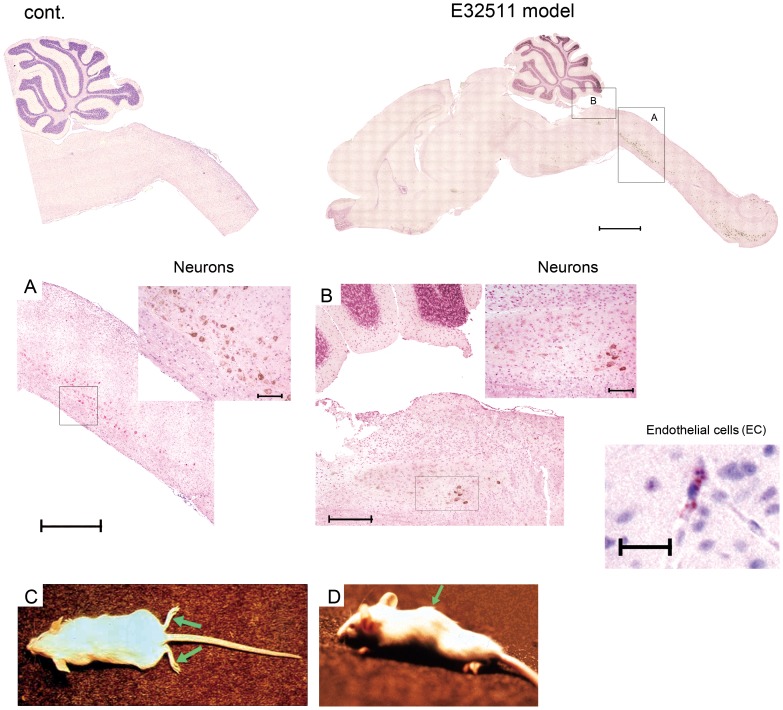
Caspase-3 activation in E32511 model mouse brain.Lesions were not detected in the brains of control (uninfected), whereas lesions were detected in the brains of E32511-infected. Scale bars: 1.5 mm. (A) Caspase-3 activation was detected in the neurons of the mouse spinal cord. Scale bars: 750 µm and 200 µm (inset). (B) Caspase-3 activation was also detected in neurons of the mouse reticular formation, scale bars: 300 µm and 200 µm (inset) and endothelial cells of the midbrain. Scale bars: 25 µm. (C) Four week-old female ICR outbred mice after inoculation. The representative clinical features of flaccid paralysis of the extremities were observed in ICR mice 3 to 5 days after orogastric challenge with E32511 1011 CFU/0.5 mL per mouse (green arrow). (D) Four week-old female ICR mice after inoculation. The representative clinical features of spinal deformity were observed in ICR mice 3 to 5 days after orogastric challenge with E32511/HSC 1011 CFU/0.5 mL per mouse (green arrow).